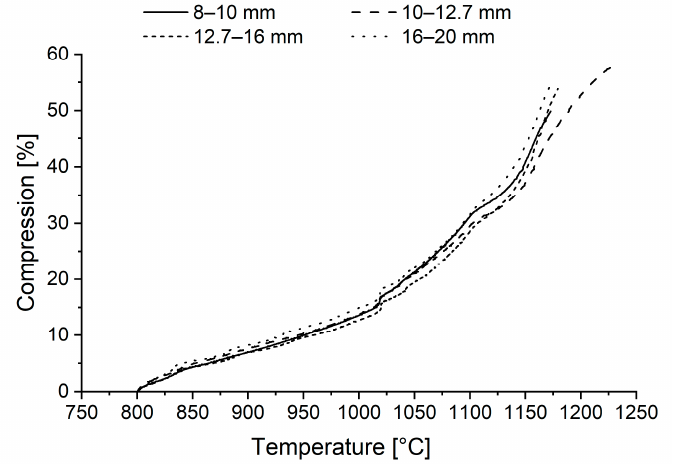
Figure 8. Evolutions of compression in the reduction-softening tests.